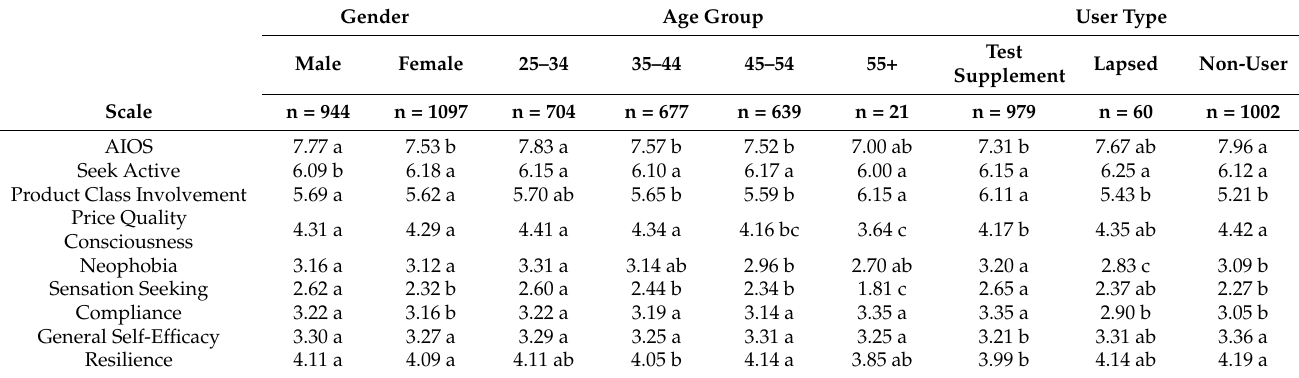
Table 7. Psychographics by gender, age group, and user type. Gender Age Group User Type Male Female 25–34 35–44 45–54 55+